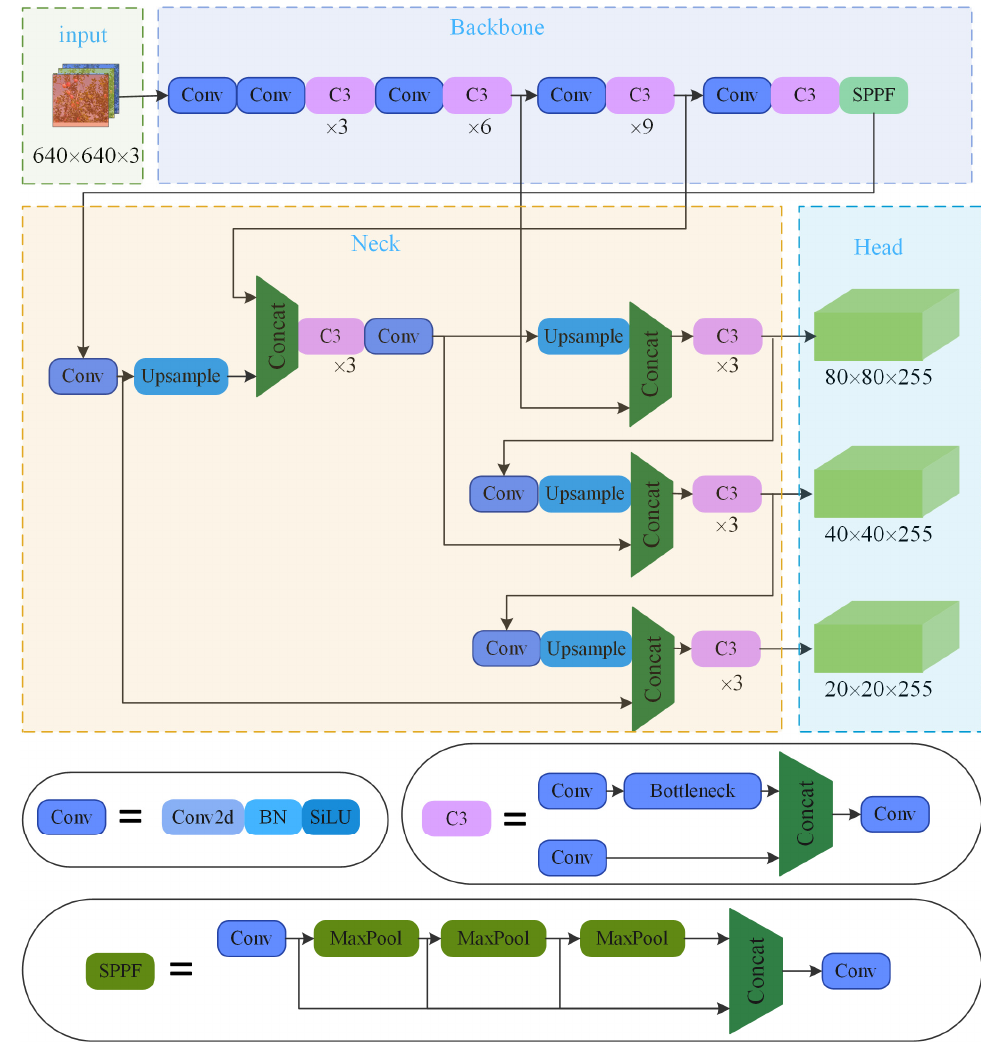
Figure 3. The architecture of the YOLOv5s method.